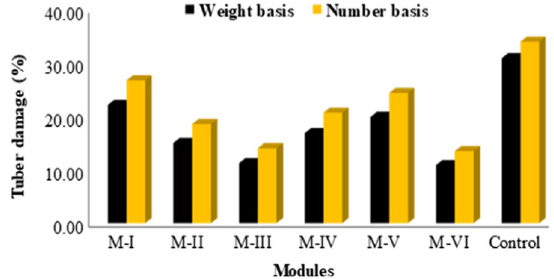
Fig. 3 Effect of different modules on per cent of tuber damage caused by Lepidiota mansueta in potato crop during 2020–2021